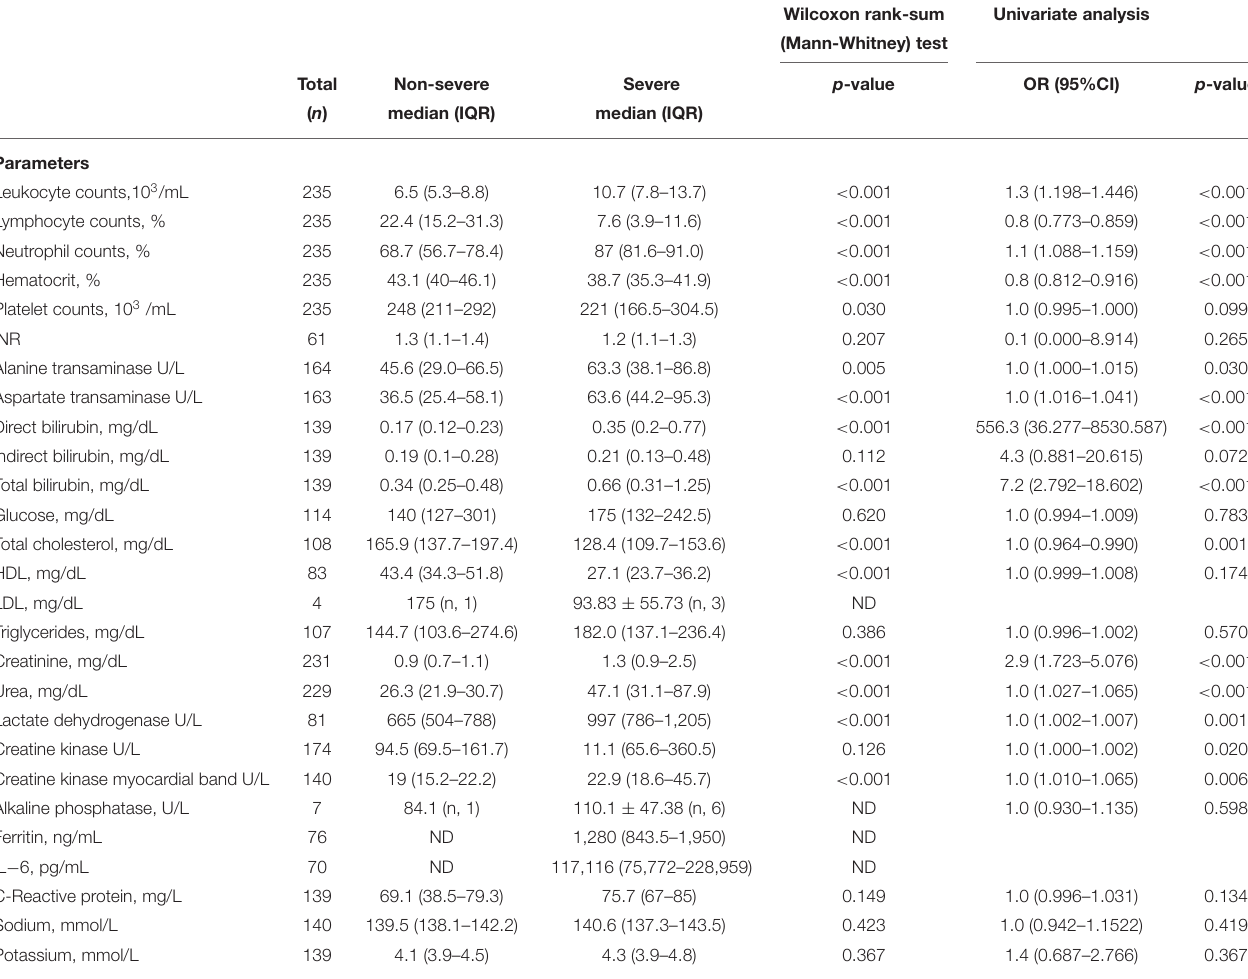
TABLE 3 | Baseline clinical laboratory characteristics of the enrolled subjects: comparison of laboratory parameters between groups and tests of association.